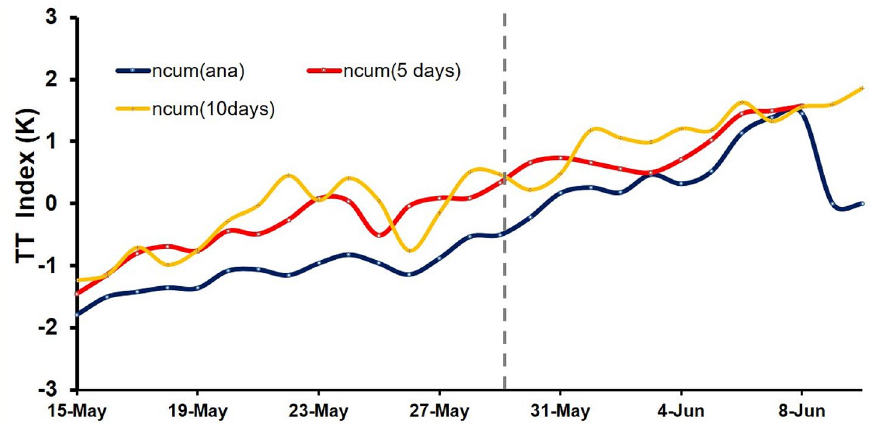
Fig. 6 The time series of NCUM analysis, 5-day and 10-day forecast of troposphere temperature index (K) during 15 May—10 June 2018. The vertical line represents the